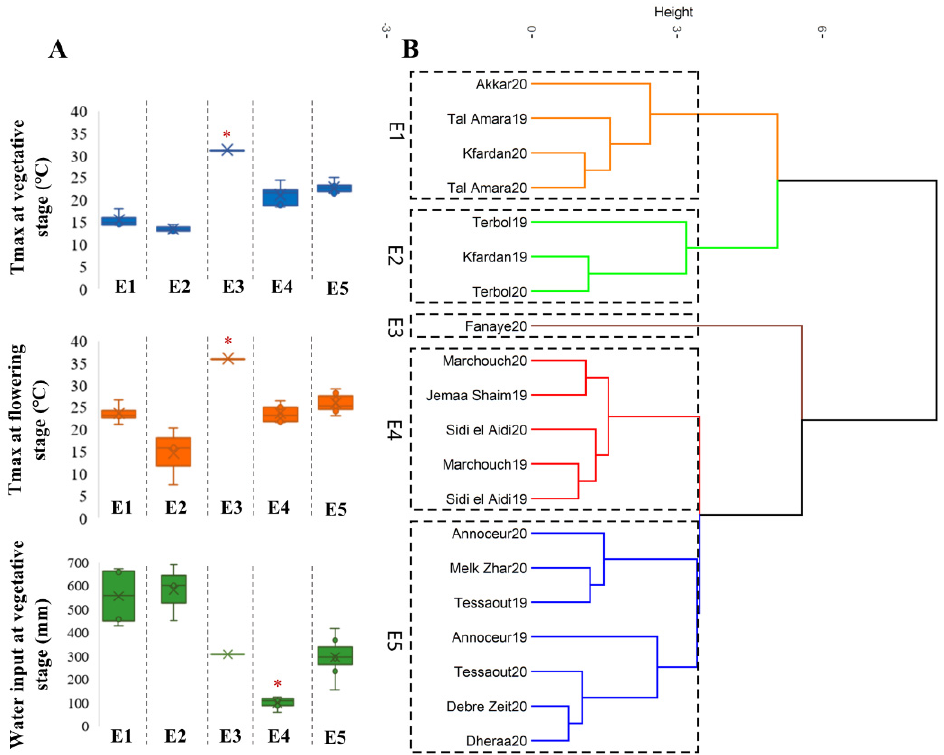
Figure 3. Box whiskers of variation for critical climatic factors ( A ) across hierarchical clusters of environments ( B ) determined based on climatic factors having a significant effect on grain yield of durum wheat, barley, and lentil genotypes (maximum temperatures at vegetative stage, maximum temperatures at flowering stage, and water input at vegetative stage). “*” indicates a significantly different response for the trait.